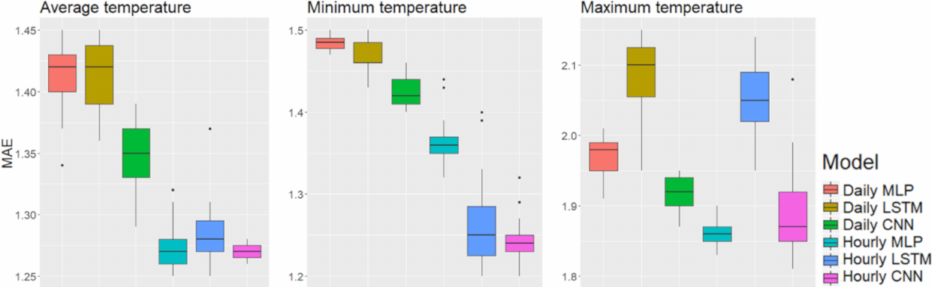
Figure 6. Box plots of the best performance among the di ff erent input lengths in the coastal area,